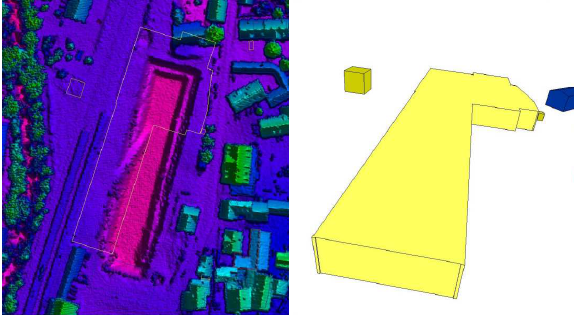
Figure 9. Determination of a standard height due to missing LiDAR-data for a new